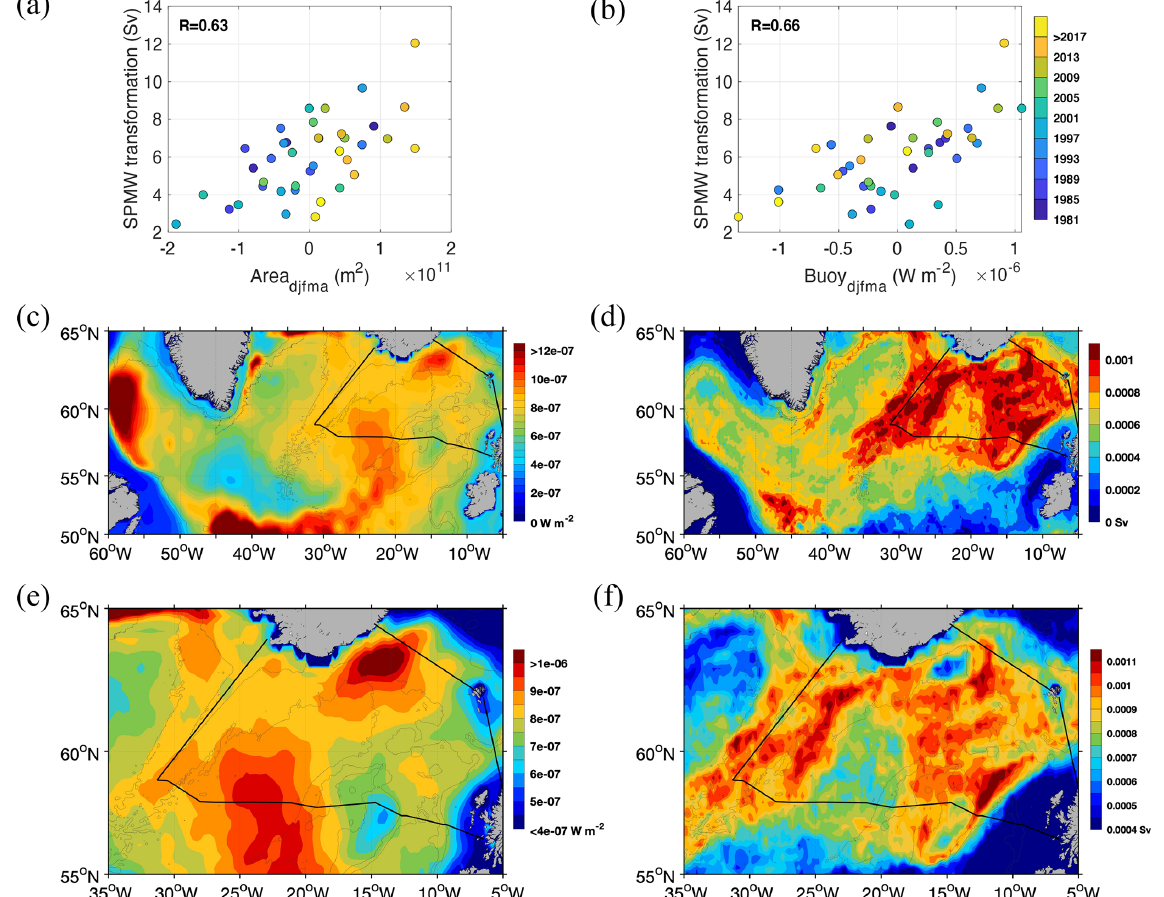
Figure 3. Correlations between the SPMW transformation to densities higher than 27.4kgm − 3 in the Iceland Basin and the (a) surface area of 27.3–27.5kgm − 3 in the Iceland Basin and (b) buoyancy flux over the surface area of 27.3–27.5kgm − 3 in the Iceland Basin. The dependence between the surface area and the buoyancy flux was removed to compute their correlations with the SPMW transformation. All correlations are computed using winter values (December to April). (c,e) Variance in buoyancy flux (Wm − 2 ) in winter, with (e) a zoom of (c) over the study domain. (d,f) Distribution of the interannual variability in SPMW transformation (Sv), with (f) a zoom of (d) over the study domain. The black boxes define the Iceland Basin